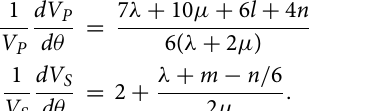
Frontiers in Earth Science |